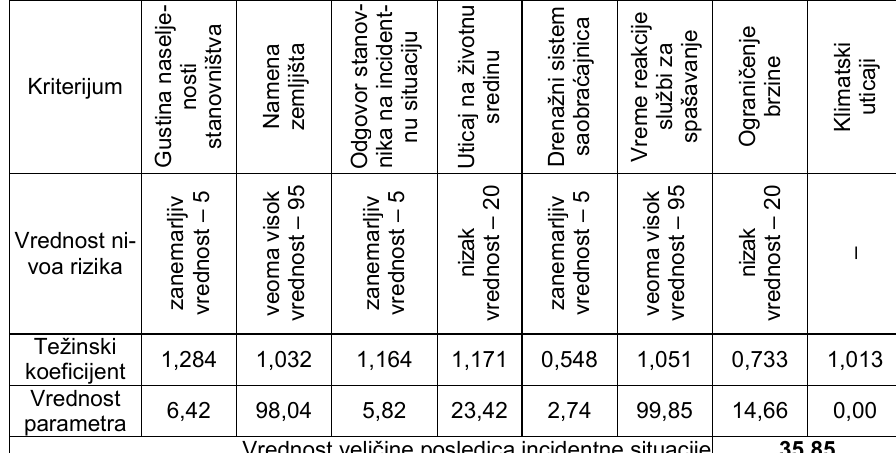
Table 4 – The values of the parameters affecting the sextent of the consequences of incidents for the section through Stepojevac